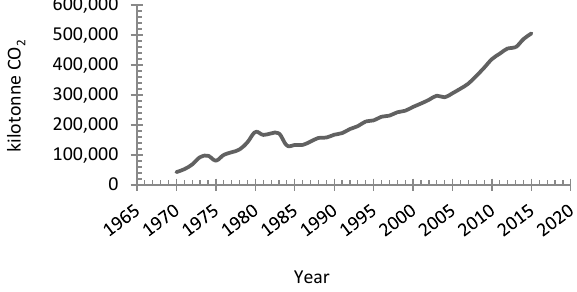
Figure 2. Emissions of greenhouse gases in Saudi Arabia by sector [2,10].